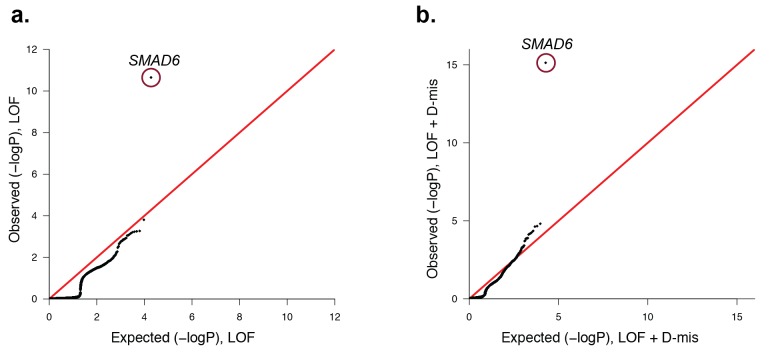
Quantile-quantile plots comparing all transmitted, damaging variants in protein-coding genes in 191 probands with midline craniosynostosis to the expected binomial distribution.De novo variants were excluded from this analysis, leaving 1122 rare (ExAC allele frequency < 2 x10−5), transmitted LOF variants and 3115 transmitted damaging (LOF + D-mis) variants. All genes closely matched expectation, with the exception of SMAD6. (a) There were 6 transmitted SMAD6 LOF mutations, a 118-fold enrichment compared to the expected 0.05 (p=2.2 × 10–11). (b) Similarly, there were 10 transmitted damaging SMAD6 variants, a 71-fold enrichment compared to the expected 0.14 (p=7.0 × 10–16). The results demonstrate genome-wide significance of rare transmitted variants in SMAD6 independent of de novo mutations.